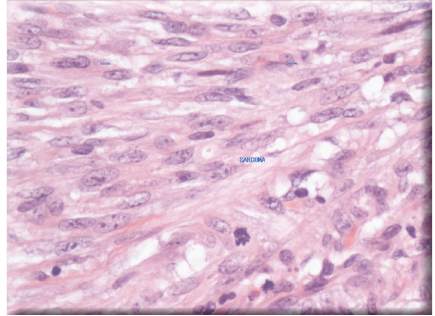
Figure 1: Staging MRI demonstrating low rectal mass, invading potential anterior resection margin.